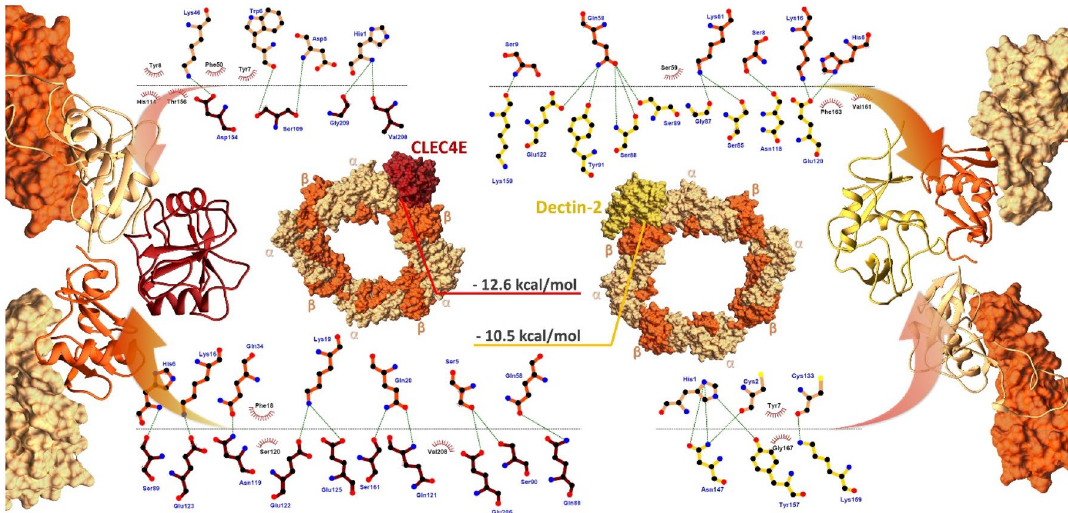
Figure 6. Complexes formed in the interaction of CVX (β subunits in orange and α subunits in sandy brown) with ectodomains of C-type Lectins receptors CLEC4E (red) and Dectin-2 (yellow). The complexes displayed above are the extracted central structures from the largest cluster of each respective MD trajectory, both structures are approximations of the most predominant conformations assumed by these proteins during 10 ns of simulation. The ΔG in kcal/mol of each interaction interface is highlighted in lines colored according to its complex of origin. Residues coordinating the interaction interfaces are highlighted on the interaction maps with hydrogen bonds depicted in green dashed lines and hydrophobic interactions highlighted in red